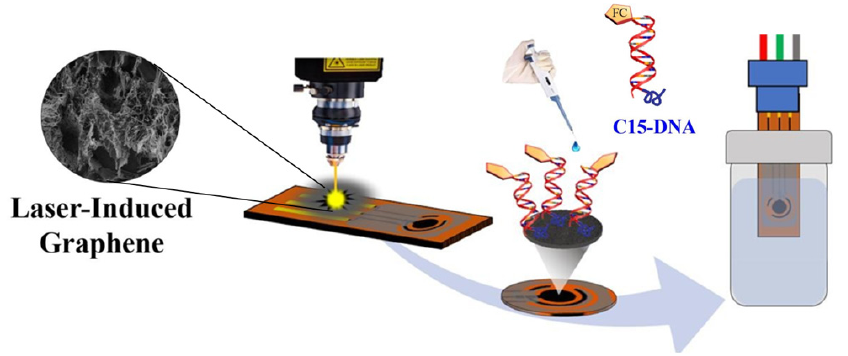
Figure 14. Method of fabricating a laser-induced graphene biosensor substrate and construction of the receptor layer of an electrochemical “turn-off” sensor with ferrocene as label. Adapted with permission from Bahri et al. [105] (copyright © (2023), Elsevier).